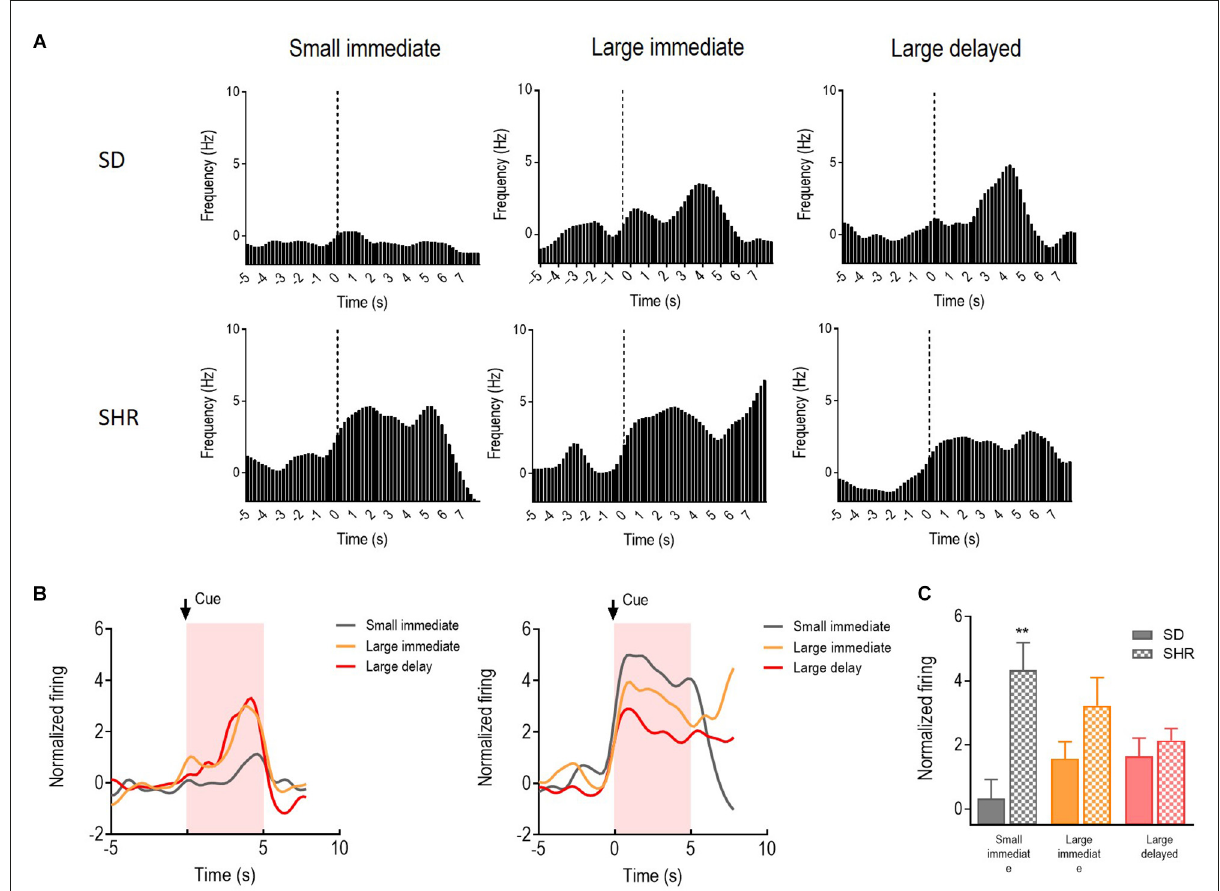
FIGURE5 The mPFC neurons respond to reward-predicting cues in SD and SHR rats. (A) Peri-event histograms of representative mPFC neurons in SD rats (upper panel) and SHR rats (lower panel) in response to the reward-predicting cue. Data are aligned to cue onset (cue sound starts at time 0, dashed line, last for 3 s). (B) Normalized firing response of all mPFC neurons’ response to sized reinforcer in SD rats (left panel) and SHR (right panel) rats. (C) Quantification of the normalized firing rate of mPFC neurons in both SD and SHR rats during the 3 s period of cue presentation (highlighted box). ** p < 0.01 compared with SD